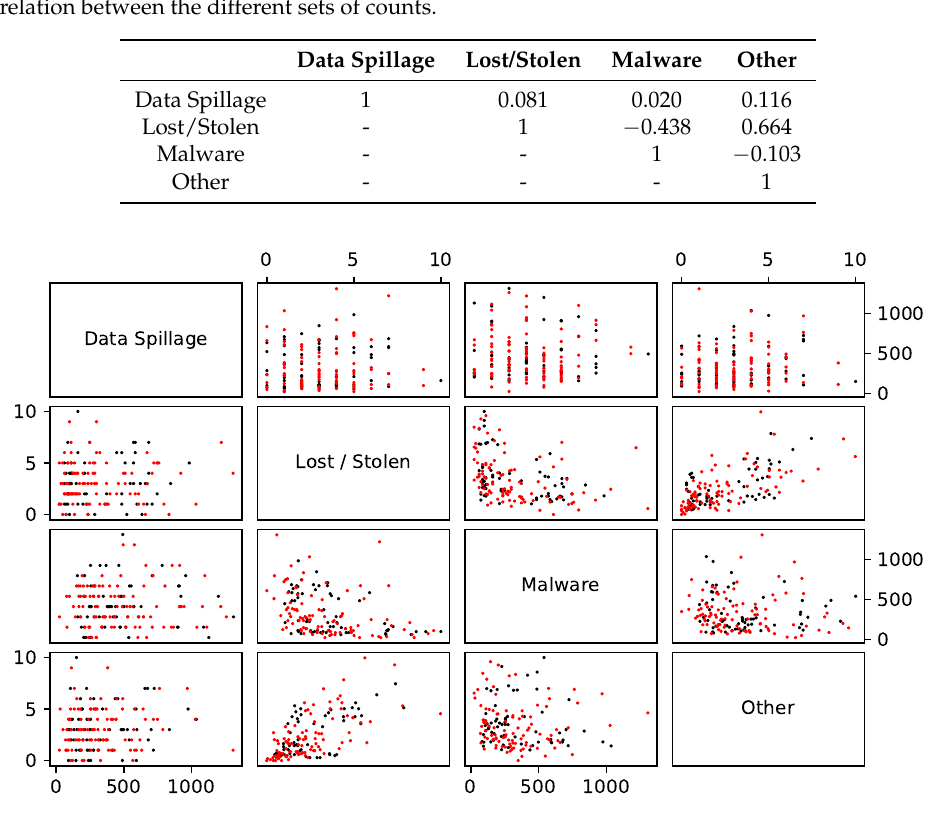
Figure 5. In black: the observed counts plotted against one another. In red: 100 simulated values of the counts under a Gaussian copula with the correlations given in Table